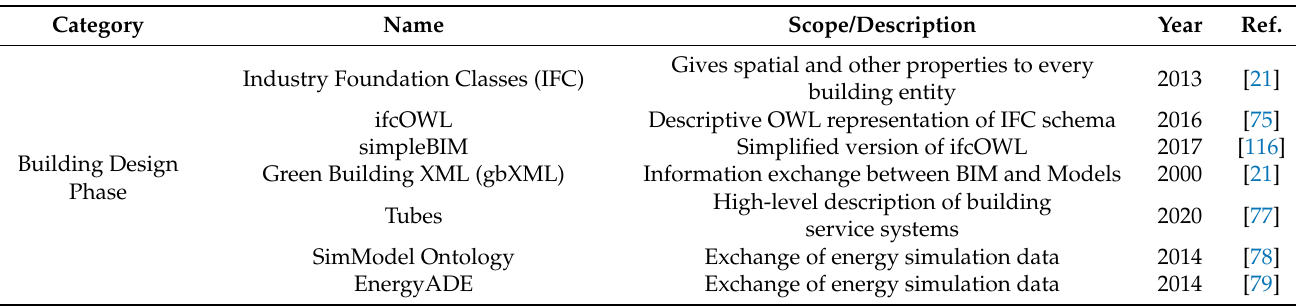
Table 1. Reviewed ontologies for